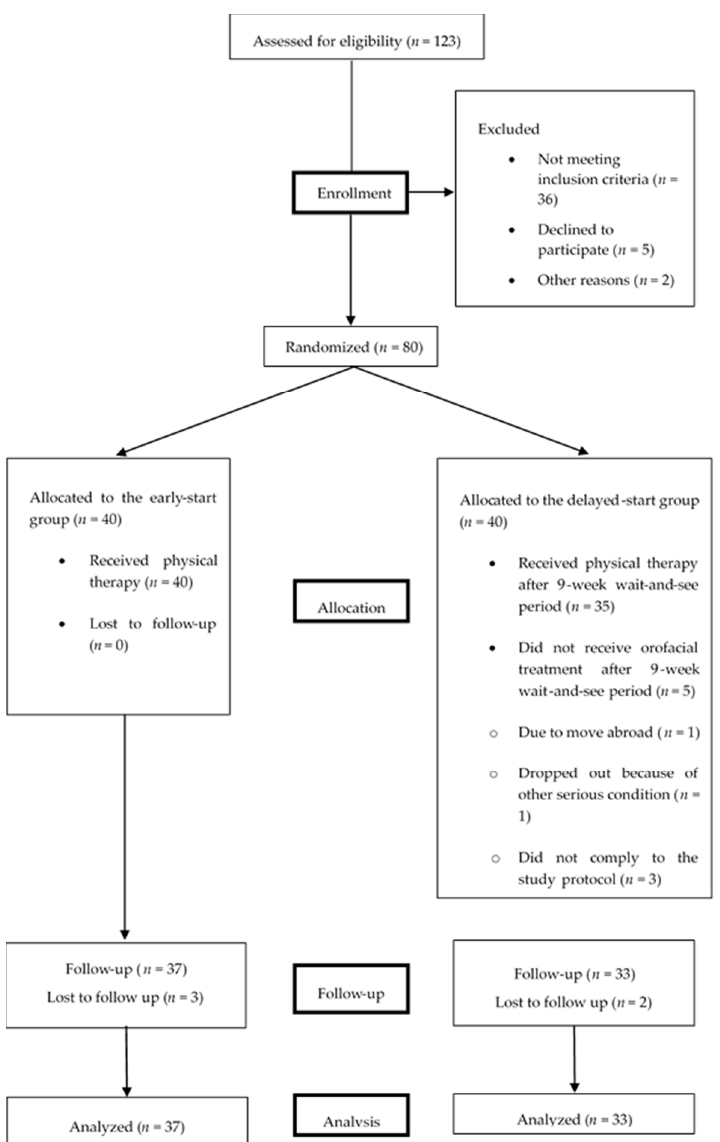
Figure 1. Flow chart of participation of the patients through the study.